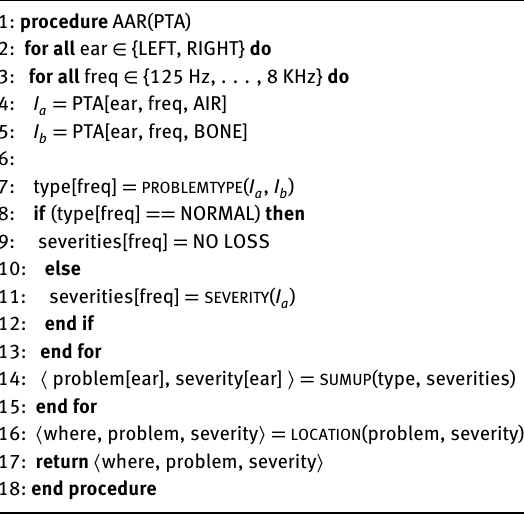
Algorithm 1: Automated audiometric